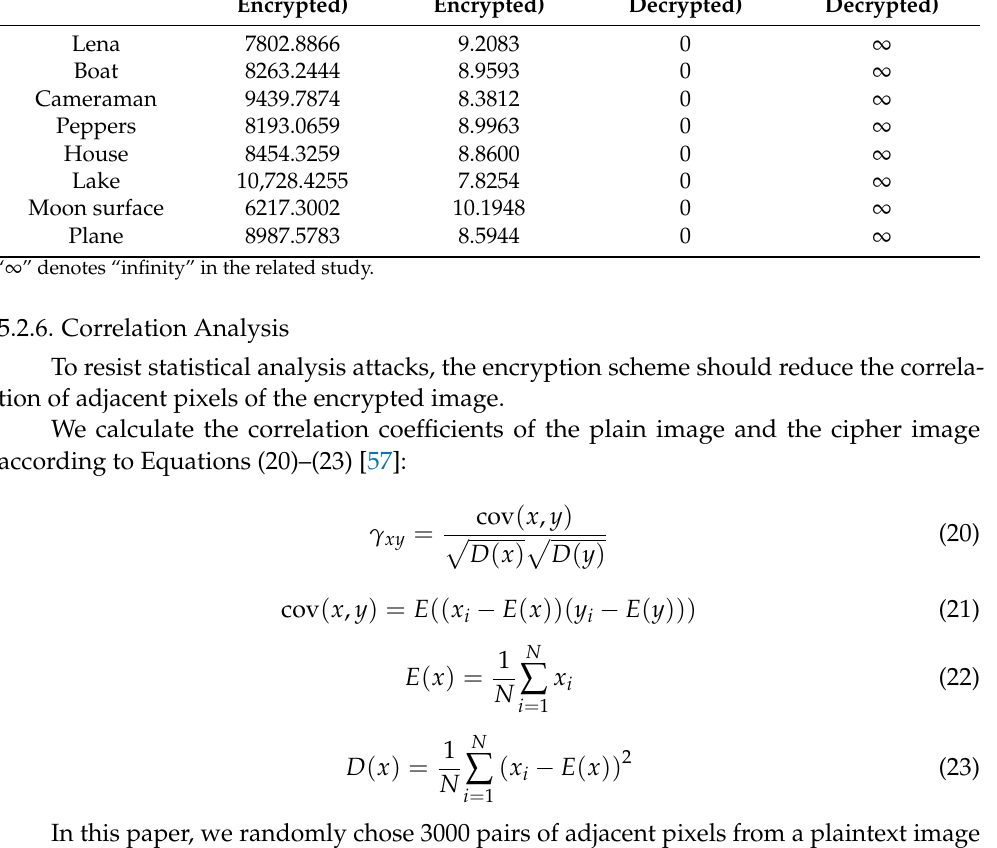
Table 4. Test results of the encryption and decryption performances by different metrics.